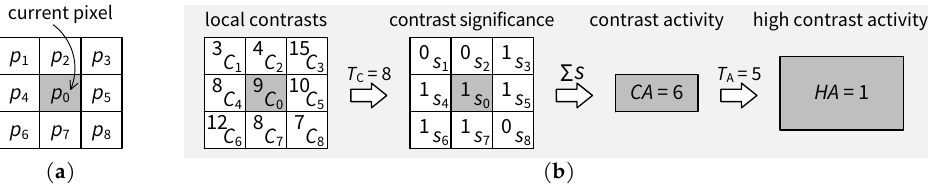
Figure 7. Illustration of contrast activity detection: ( a ) neighborhood for local contrast estimation; and ( b ) example of local contrasts, contrast significance and derivation of the high-contrast-activity